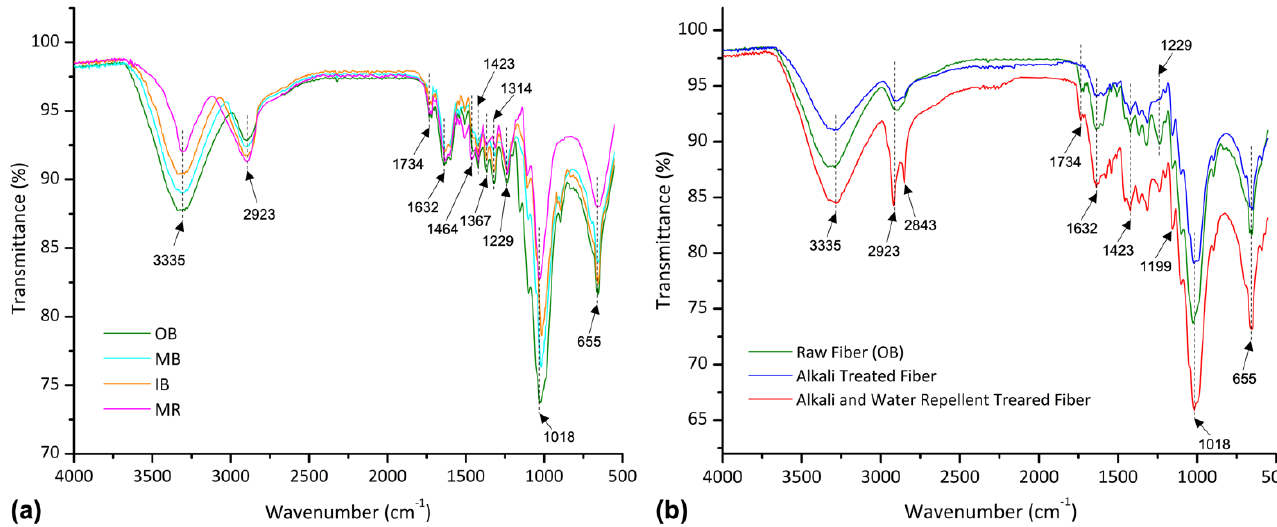
Figure 3. FTIR spectroscopy of ( a ) different types of raw banana fibers, ( b ) raw, alkali-treated, and water repellent-treated banana fiber nonwovens.